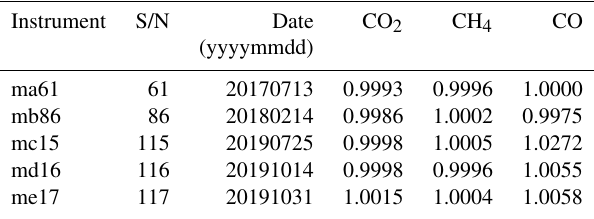
Table B2. Scaling factors according to Frey et al. (2019) of our five EM27/SUN instruments with respect to the reference EM27/SUN (S/N 037) at